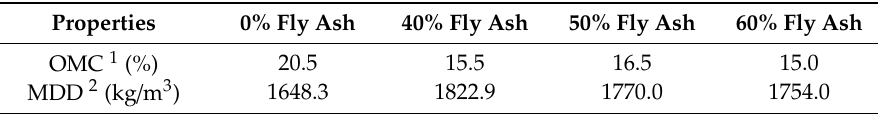
Table 2. Variations of OMC and MDD with fly ash content.